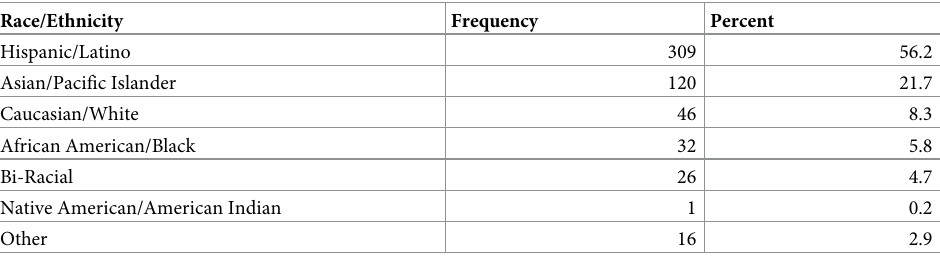
Table 1. Racial and ethnic